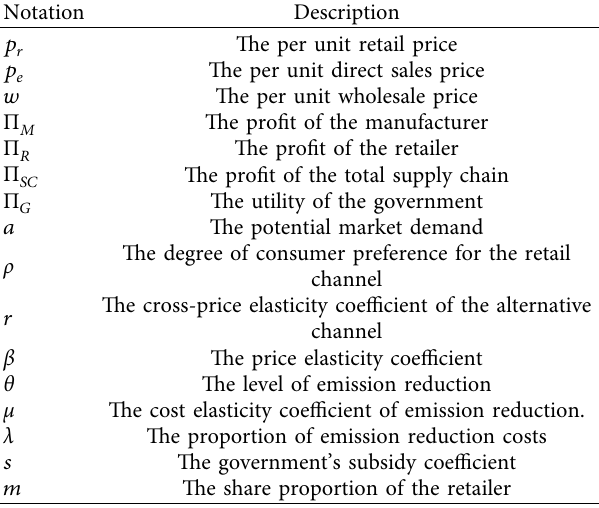
Figure 1: Dual-channel supply chain structure. Table 1: The description of the